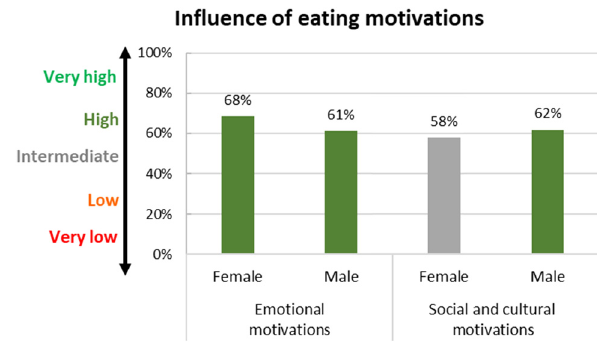
Figure 2: Level of in fl uence of eating motivations according to gender.